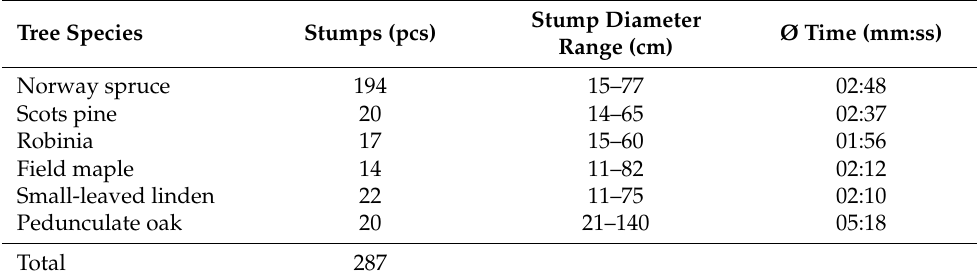
Table 4. Representation of tree species and stumps (including their diameter) for the comparison of time required for processing one